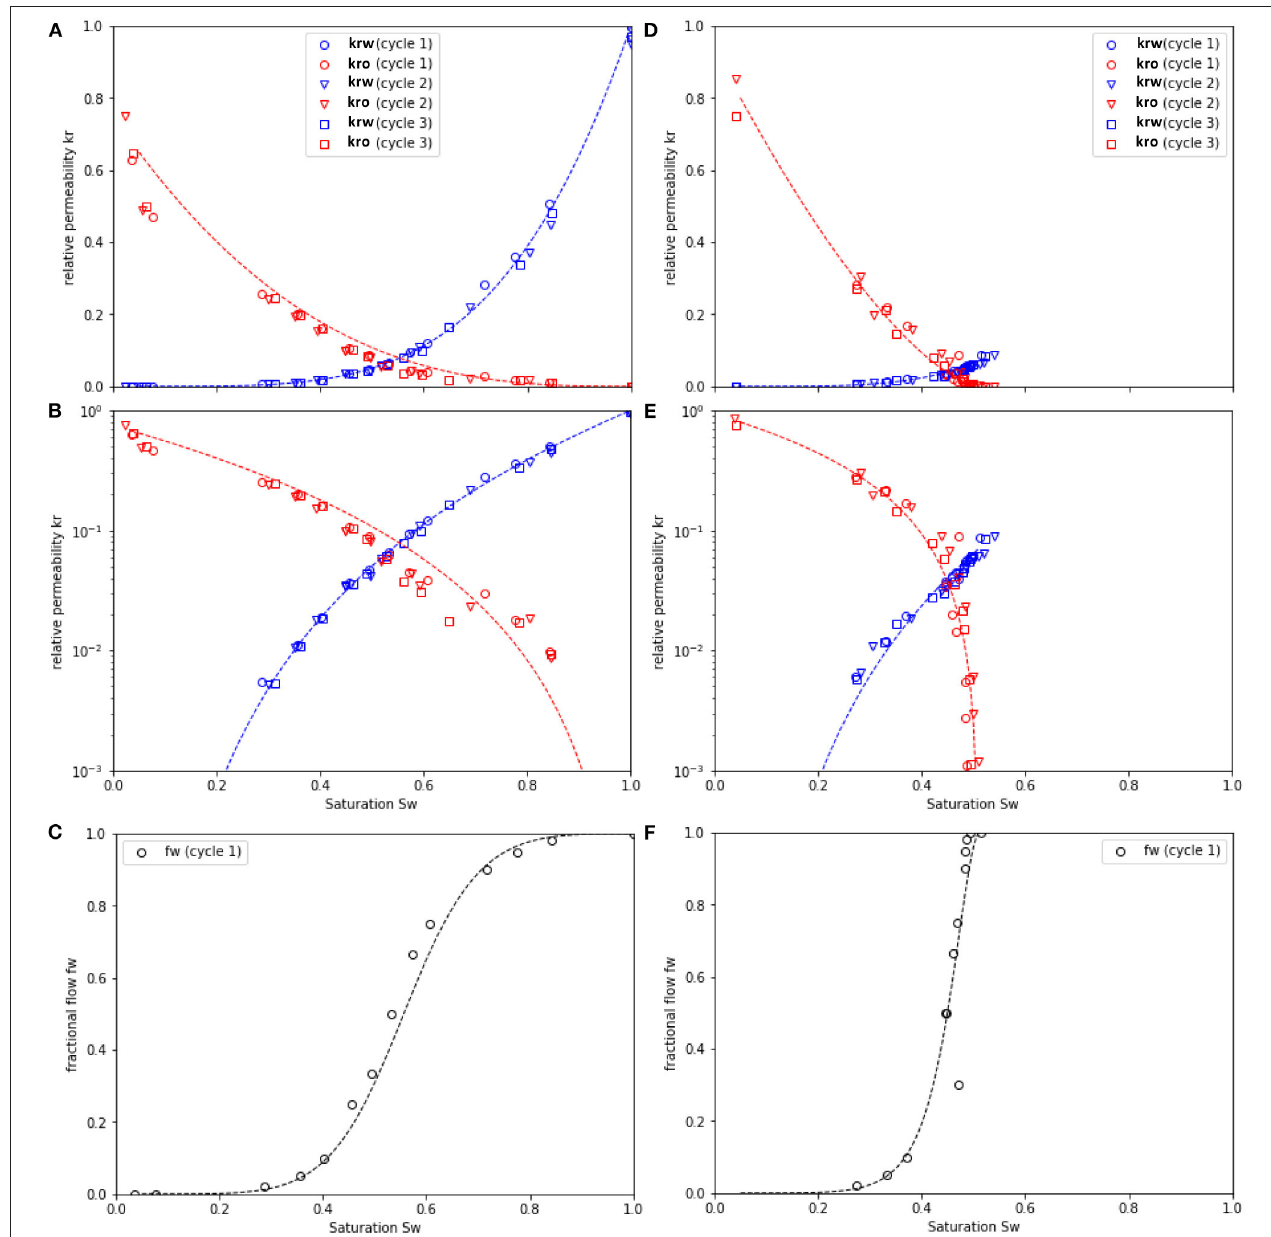
FIGURE 7 | Relative permeability for water (blue) and oil (red) for the SCAL experiment with the strongly water-wet Fontainebleau sandstone sample for the 1st, 2nd, and 3rd cycles for drainage (A–C) and imbibition (D–F) . Each cycle consisted of drainage, followed by imbibition, and sub-sequent in-situ cleaning of the sample with iso-propanol inside the setup without unmounting/remounting the sample. There is excellent repeatability between individual experiments. The dotted lines show a Corey fit of the data. The fractional flow functions f w ( S w ) for the first drainage and imbibition cycle are shown in (C,F) , respectively.